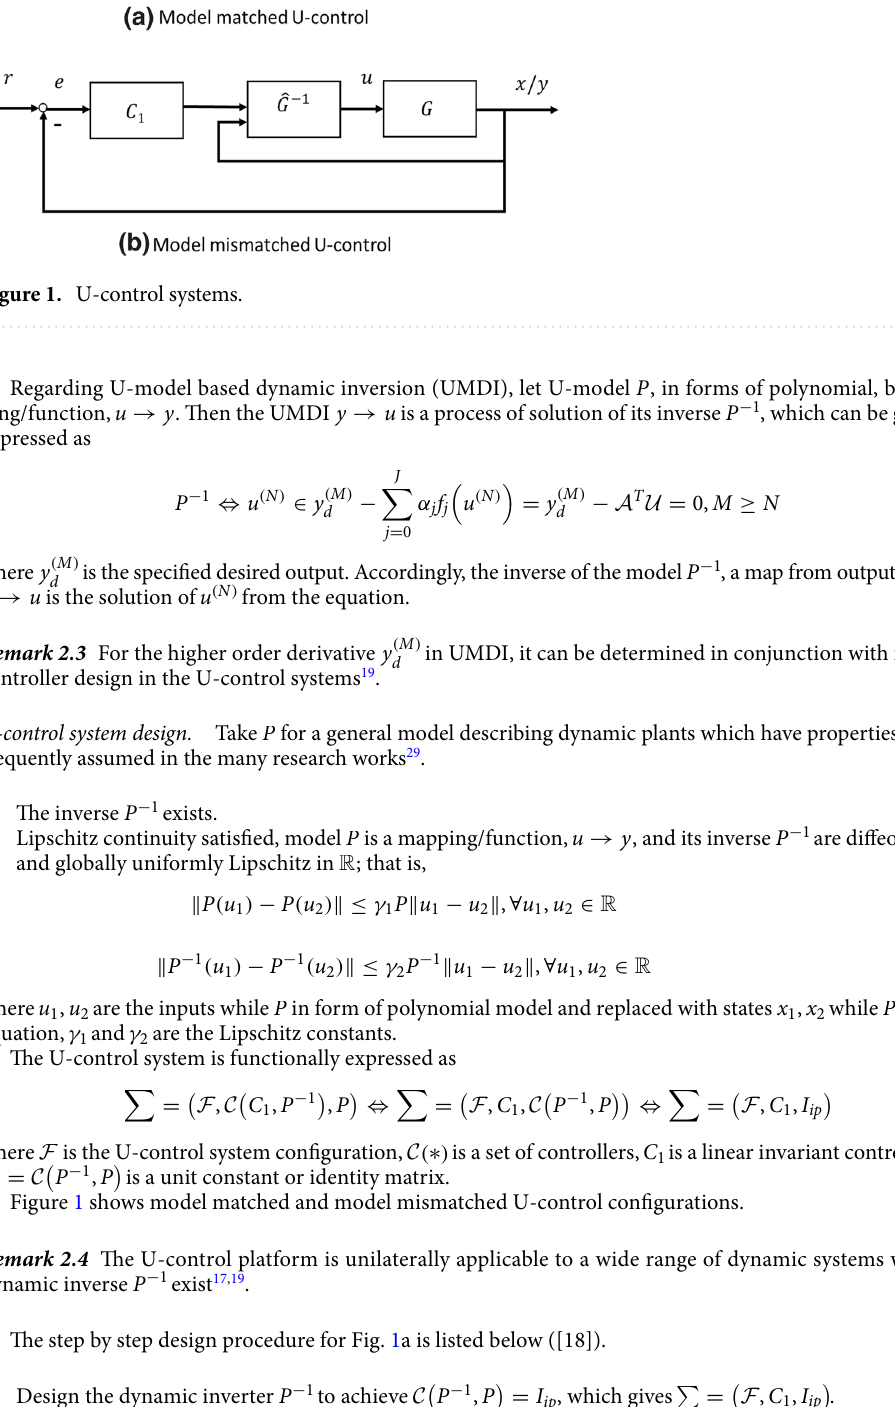
2. Design the invariant controller C 1 under